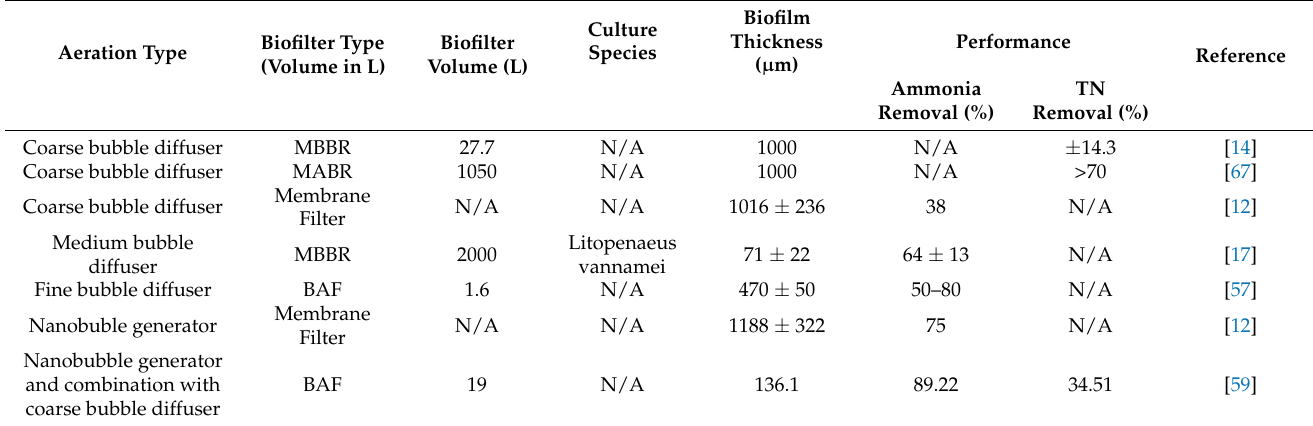
Table 4. Summary of biofilm thickness in the